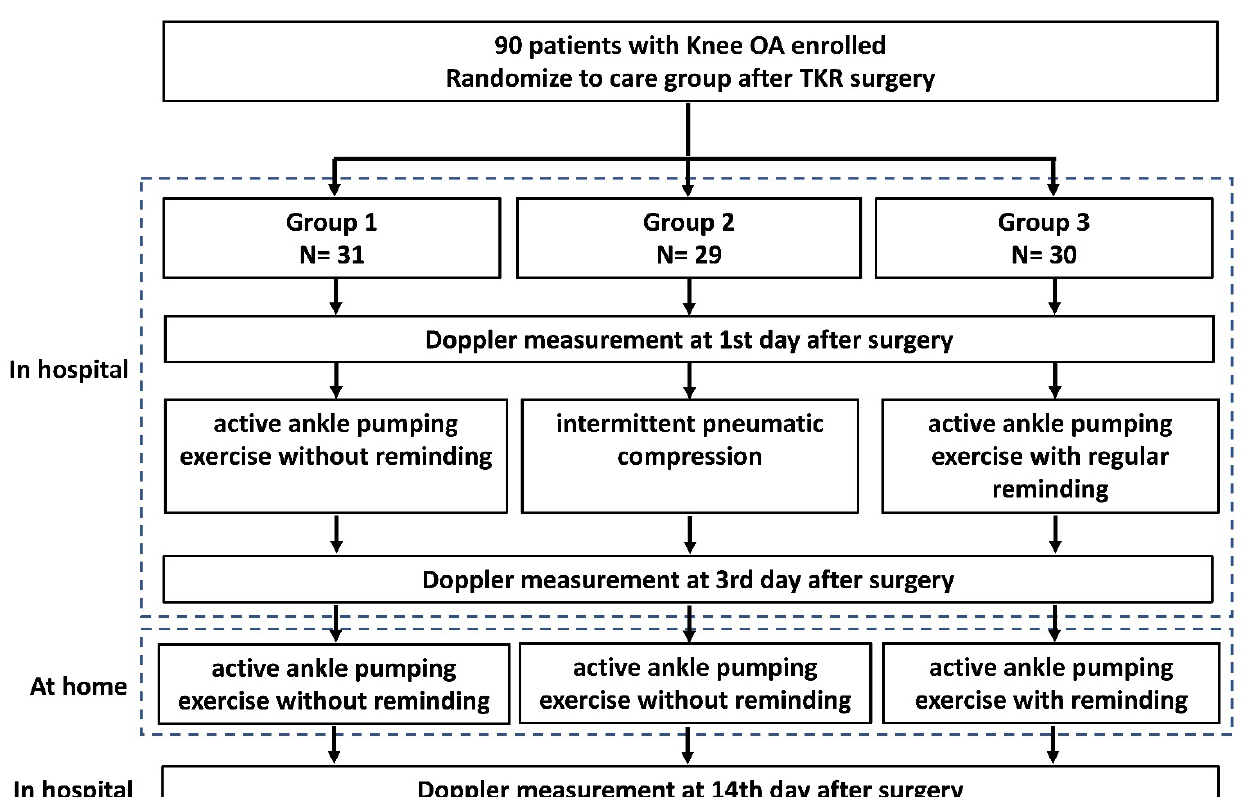
Figure 1. Flowchart of the present study. OA: osteoarthritis.